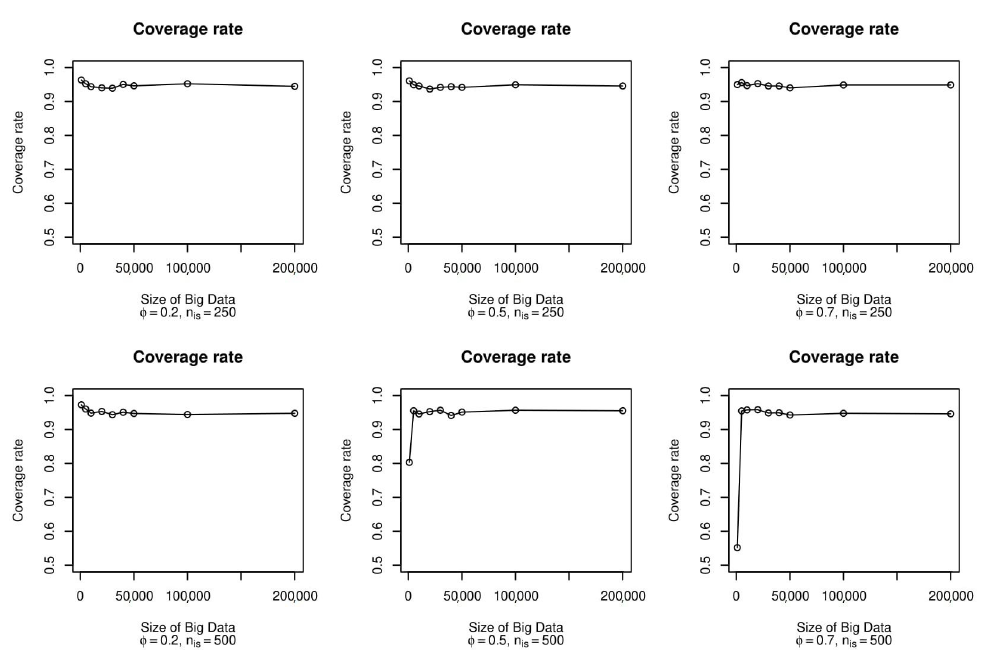
Figure 3. Coverage rate for the mean parameter, according to the size of the big data, φ , and n is